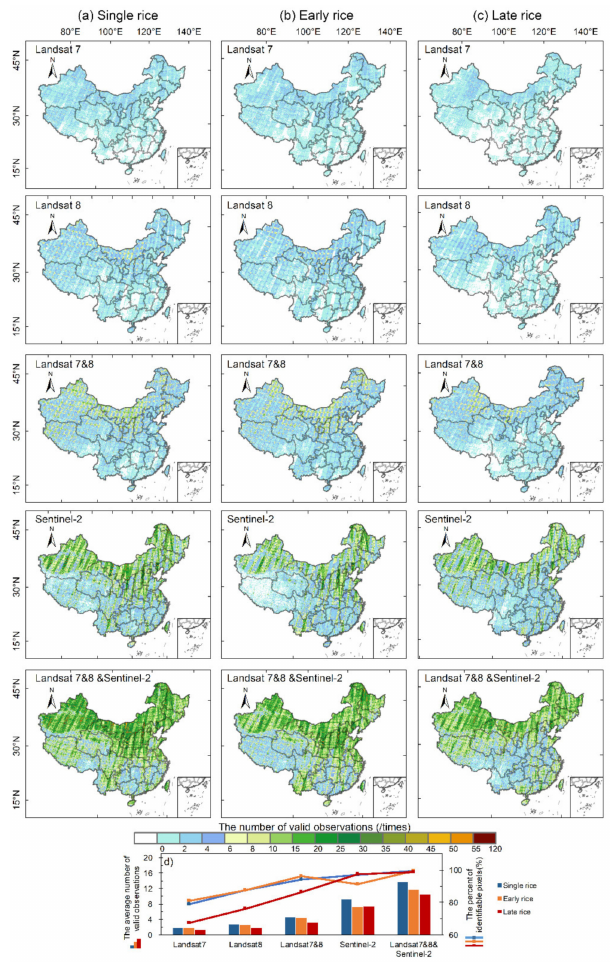
Figure 3. Spatial distributions of valid Landsat and Sentinel observations during the flooding and rice transplanting period of: ( a ) single rice, ( b ) early rice, and ( c ) late rice across China in 2020; ( d ) shows the average number of valid observations (bars) and the percentage of identifiable rice pixels (lines with symbols) with various combinations. It should be noted that although northern China is not suitable for planting early and late rice due to insufficient accumulated temperature, we show the valid observations during the periods with flooding signals of early rice and late rice in this region in order to fully demonstrate the distribution of valid observations across